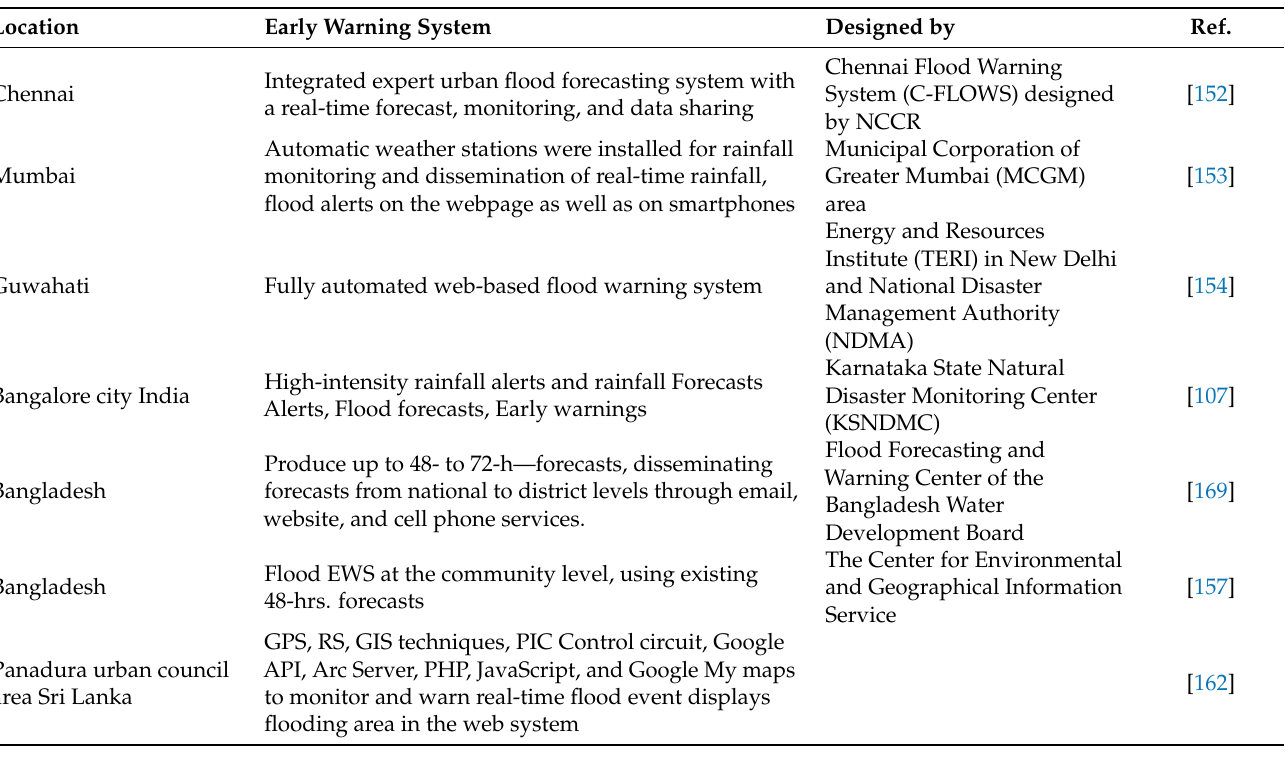
Table 3. Some of the early warning systems in